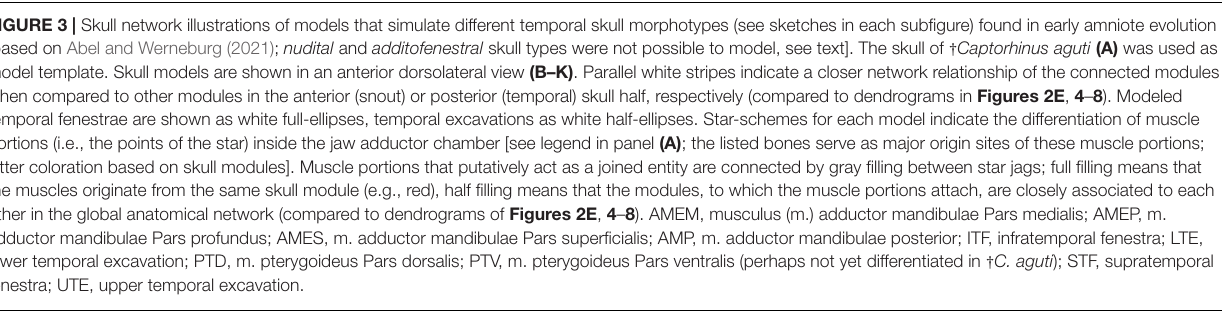
FIGURE 3 | Skull network illustrations of models that simulate different temporal skull morphotypes (see sketches in each subfigure) found in early amniote evolution [based on Abel and Werneburg (2021); nudital and additofenestral skull types were not possible to model, see text]. The skull of † Captorhinus aguti (A) was used as model template. Skull models are shown in an anterior dorsolateral view (B–K) . Parallel white stripes indicate a closer network relationship of the connected modules when compared to other modules in the anterior (snout) or posterior (temporal) skull half, respectively (compared to dendrograms in Figures 2E , 4 – 8 ). Modeled temporal fenestrae are shown as white full-ellipses, temporal excavations as white half-ellipses. Star-schemes for each model indicate the differentiation of muscle portions (i.e., the points of the star) inside the jaw adductor chamber [see legend in panel (A) ; the listed bones serve as major origin sites of these muscle portions; letter coloration based on skull modules]. Muscle portions that putatively act as a joined entity are connected by gray filling between star jags; full filling means that the muscles originate from the same skull module (e.g., red), half filling means that the modules, to which the muscle portions attach, are closely associated to each other in the global anatomical network (compared to dendrograms of Figures 2E , 4 – 8 ). AMEM, musculus (m.) adductor mandibulae Pars medialis; AMEP, m. adductor mandibulae Pars profundus; AMES, m. adductor mandibulae Pars superficialis; AMP, m. adductor mandibulae posterior; ITF, infratemporal fenestra; LTE, lower temporal excavation; PTD, m. pterygoideus Pars dorsalis; PTV, m. pterygoideus Pars ventralis (perhaps not yet differentiated in † C. aguti ); STF, supratemporal fenestra; UTE, upper temporal